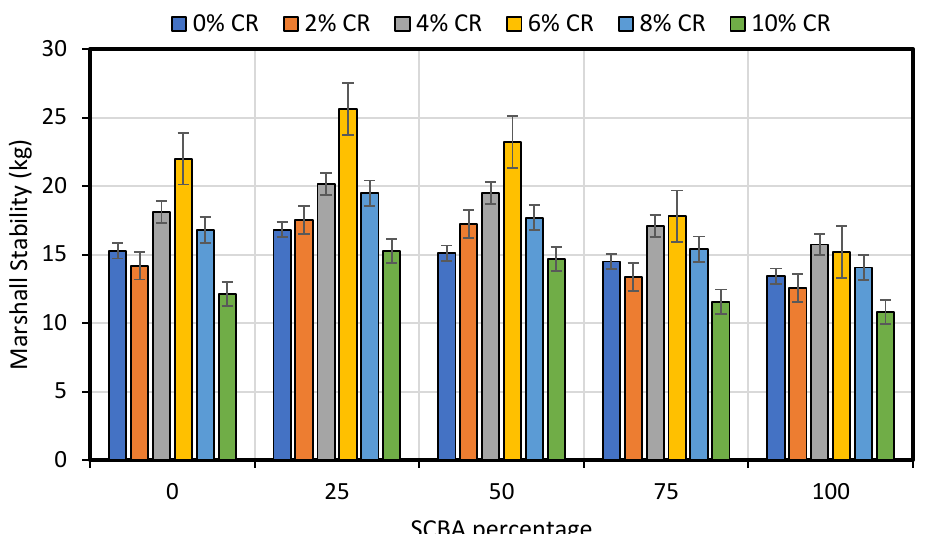
Figure 9. Effect of additions of CR and SCBA on stability of asphalt concrete.